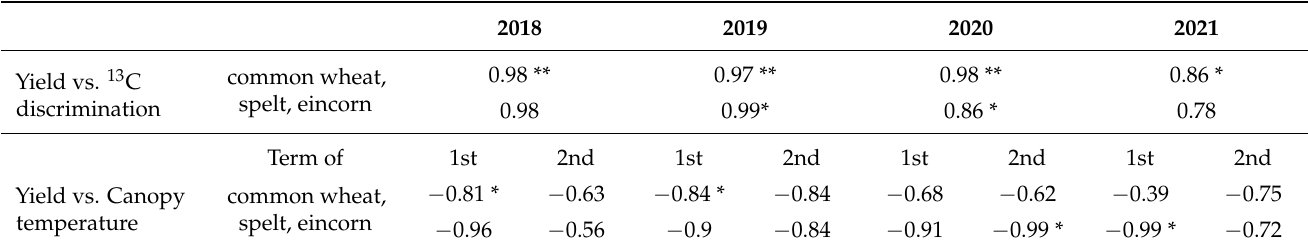
Table 5. Correlation between grain yield and grain 13 C discrimination or canopy temperature.